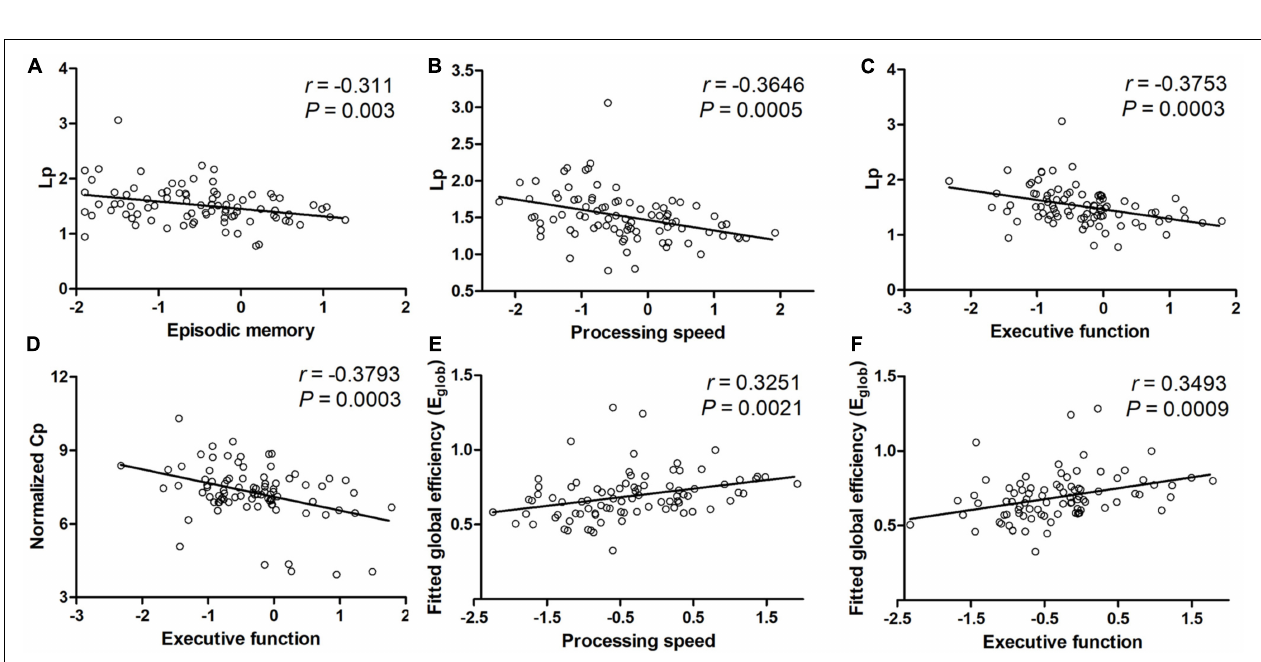
FIGURE 3 | The relationships of WM network topological properties and neuropsychological performances in patients with ILA. (A–C) Within the ILA group, the characteristic path length L p exhibited significant correlations with three cognitive domains [episodic memory ( Z scores): r = − 0.311, P = 0.003; processing speed ( Z scores): r = − 0.3646, P = 0.0005; executive function ( Z scores): r = − 0.3753, P = 0.0003]. (D) The normalized C p correlated negatively with executive function ( Z scores; r = − 0.3793, P = 0.0003) in ILA patients. (E,F) The global efficiency E glob correlated positively with the cognitive domains of processing speed ( Z scores; r = 0.3251, P = 0.0021) and executive function ( Z scores; r = 0.3493, P = 0.0009) in ILA patients. ILA, ischemic